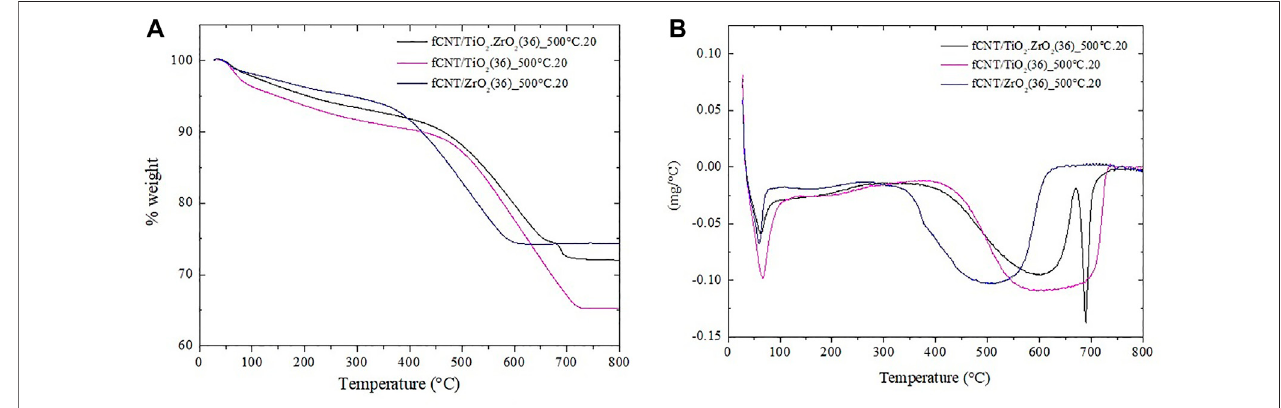
FIGURE 6 | Thermograms of nanostructured materials fCNT/MO 2 (36)500 ° C.20: (A) TGA plot and (B) DTG plot.